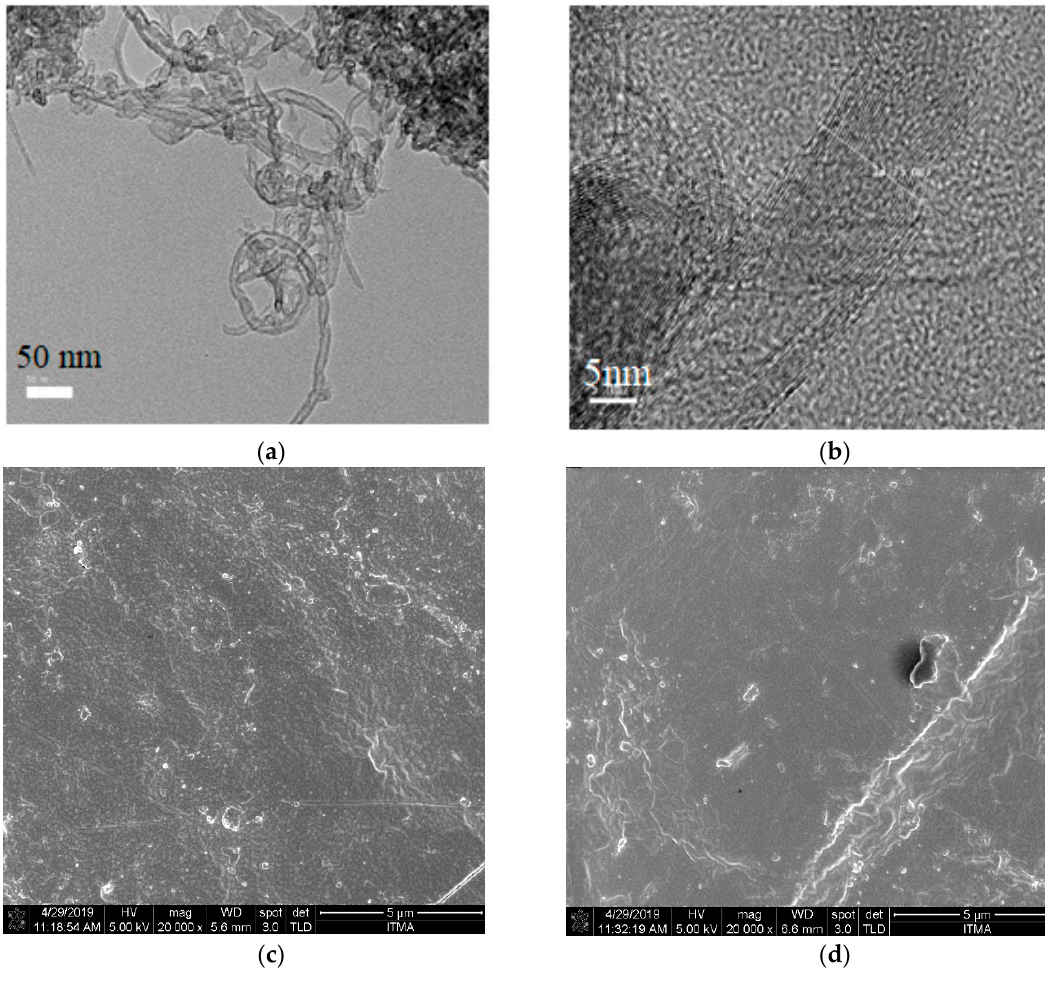
Figure 6. TEM image of ( a ),( b ) MWCNTs and FE-SEM image of ( c ) OPEFB/PLA/6% MWCNTs; ( d ) OPEFB/PLA/22% MWCNTs.